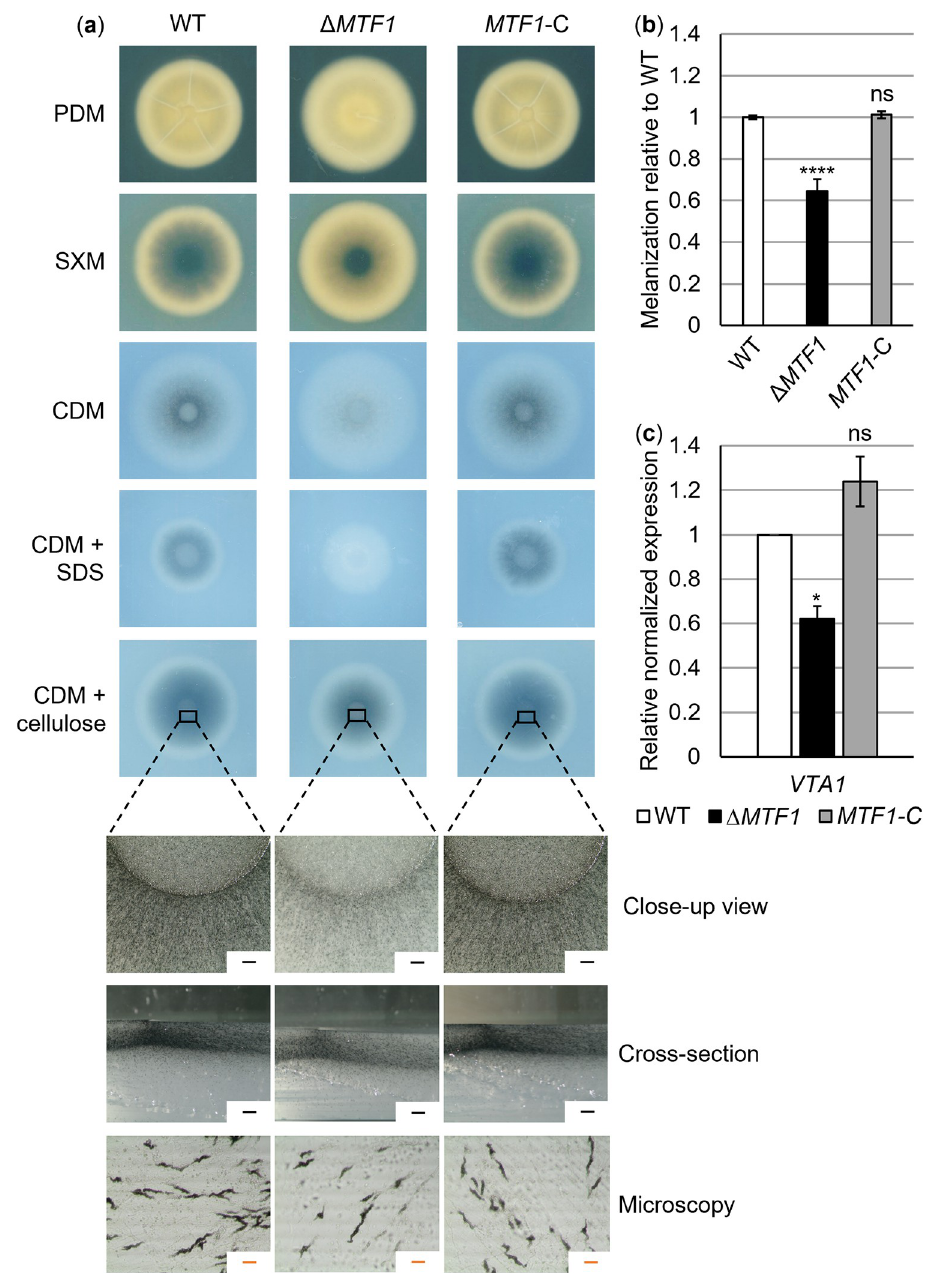
Fig 5. The transcriptional regulator-encoding gene MTF1 of Verticillium dahliae is required for formation of microsclerotia at levels comparable to the wild-type. (a, b) The ex-planta phenotype of the V . dahliae MTF1 deletion strain ( Δ MTF1 ) was compared with the JR2 wild-type (WT) and the MTF1 complementation strain ( MTF1 -C). 50,000 spores of respective strains were point-inoculated onto plates containing simulated xylem medium (SXM), potato dextrose medium (PDM) or Czapek-Dox medium (CDM) and incubated at 25˚C for 10 days. (a) Bottom view scans depict fewer microsclerotia formed by Δ MTF1 compared with the wild-type and MTF1 -C on all tested media. For CDM + cellulose plates, close-up views, cross-sections of colony centers and microscopic images of fungal material from the colony centers are shown (black scale in upper two rows = 500 μ m, orange scale in lower row = 50 μ m). (b) Melanization of fungal colonies grown on CDM + cellulose was quantified as a measure of the number of microsclerotia formed. Pictures were taken from top view scans of the colonies after removal of aerial mycelium. The brightness factor of three colonies per transformant ( n = 1) was calculated using the ROI Manager of ImageJ software. Three independent experiments were performed. Means ± SD are shown. Significant differences from wild-type were determined using t -tests. Melanization of Δ MTF1 was reduced to approximately 60% of wild-type levels ( ���� ,